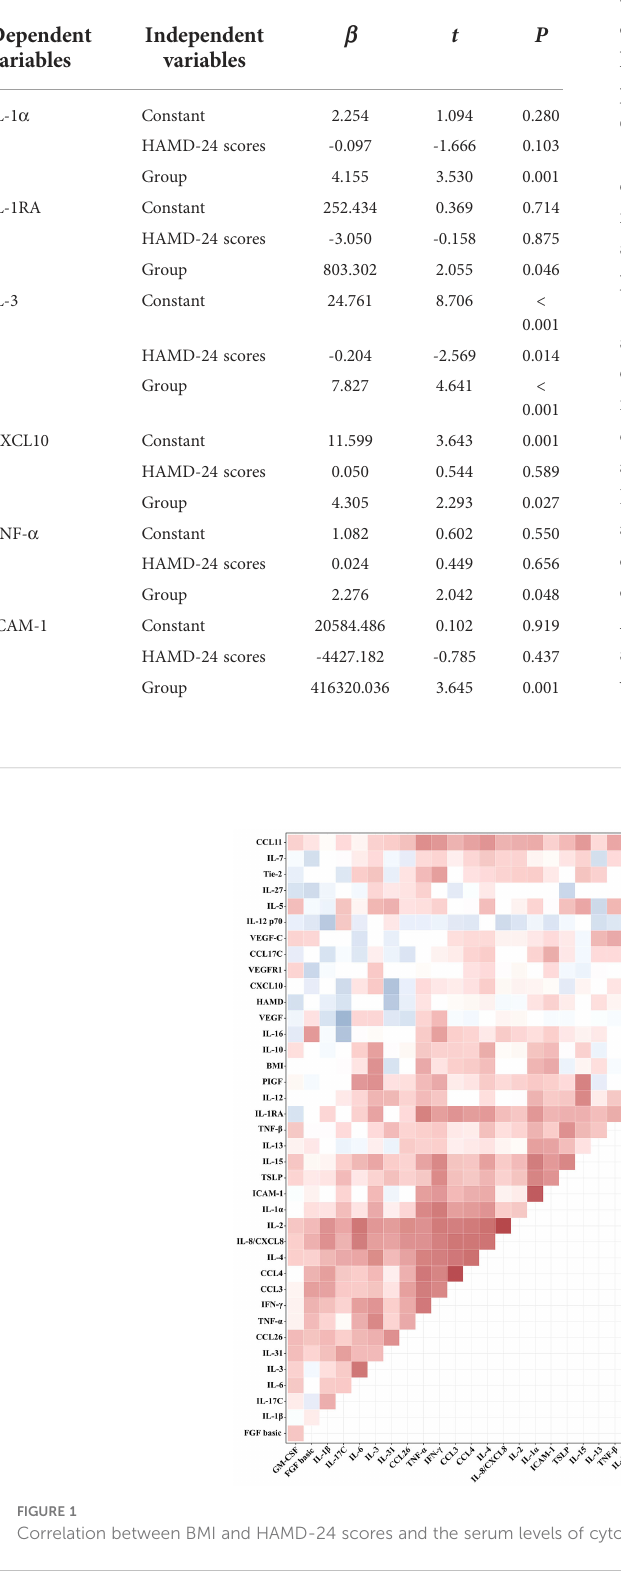
TABLE 4 Multiple linear regression analysis to determine the independent predictors (HAMD-24 scores and group) of abnormal serum cytokines levels.